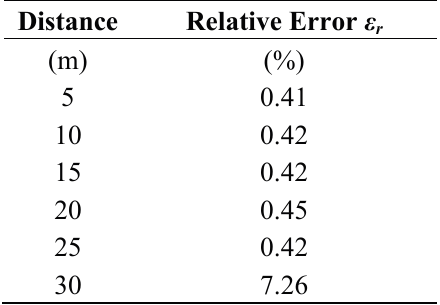
Table 2. Relative error of wirelessly transmitted signal (Indoor).